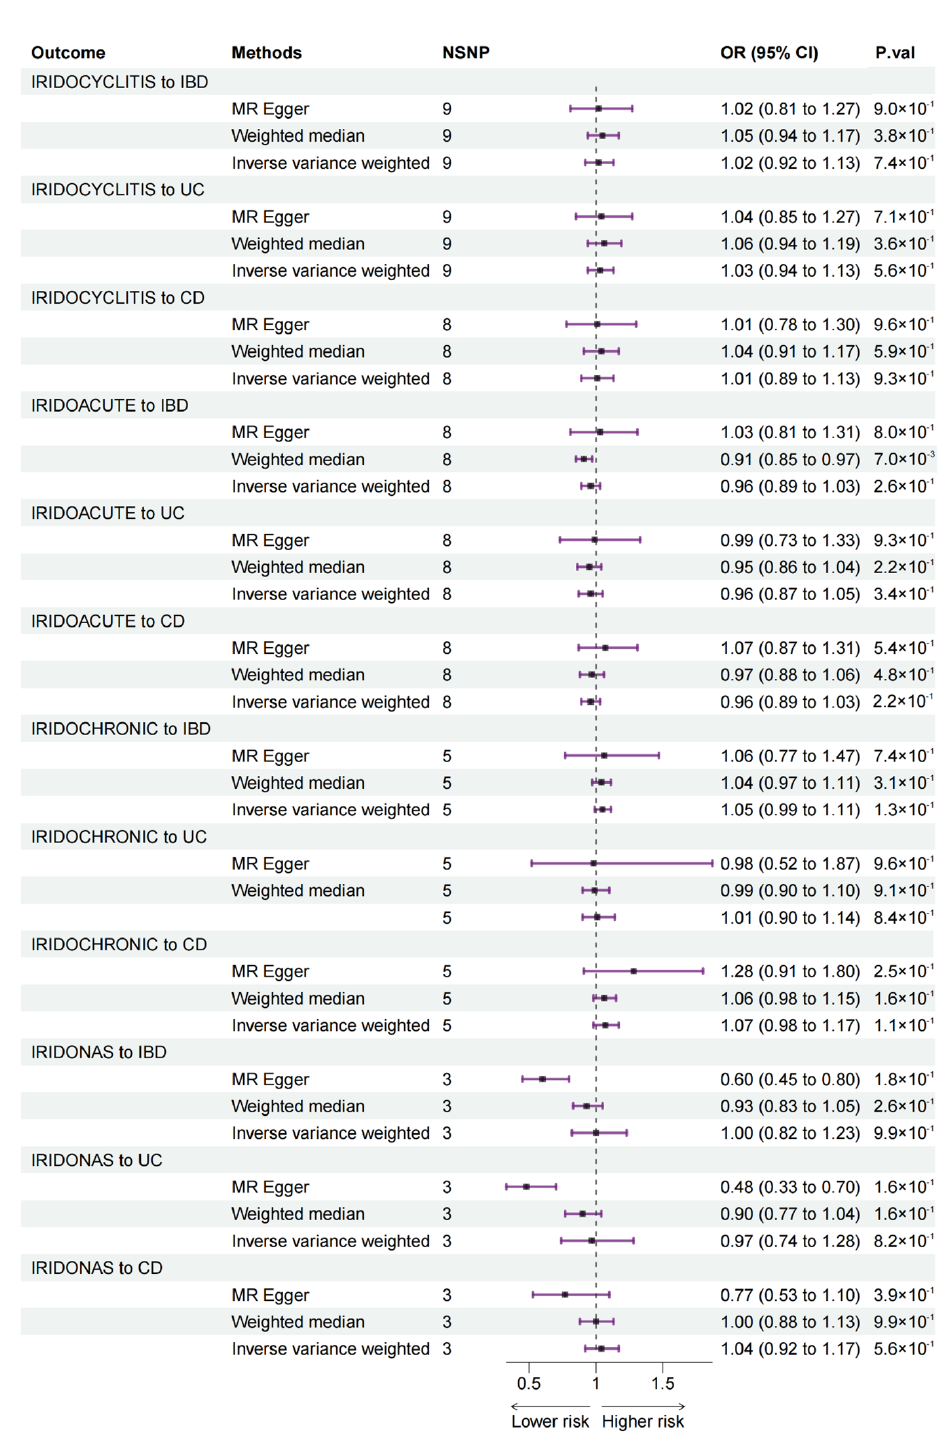
Figure 3. MR estimates from IC to IBD (including UC and CD) in bidirectional MR. MR: Mendelian randomization; IC: iridocyclitis; IBD: inflammatory bowel disease; UC: ulcerative colitis; CD: Crohn’s disease; NSNP: number of single nucleotide polymorphism; OR: odds ratio; CI: confidence interval; IRIDOCYCLITIS: IC as a whole; IRIDOACUTE: acute and subacute IC; IRIDOCHRONIC: chronic IC; IRIDONAS: other and unspecified IC. p -values < 0.0021 after Bonferroni correction were considered statistically